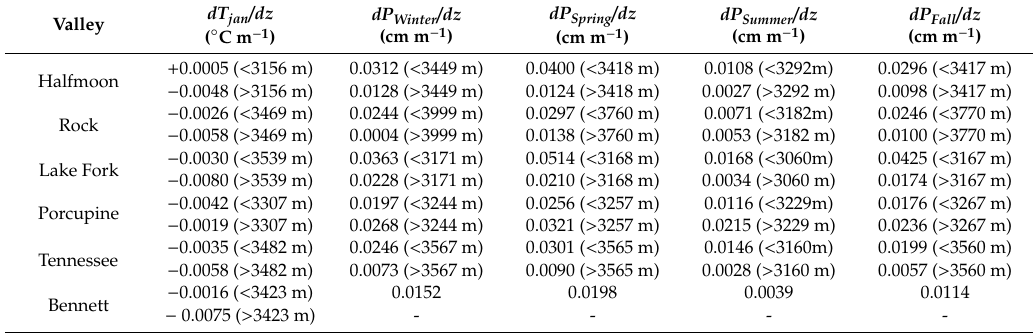
Table 1. Lapse rates and seasonal precipitation gradients for individual valleys obtained from piecewise linear fits of PRISM climatology. All values are significant at the 95% confidence interval or greater.